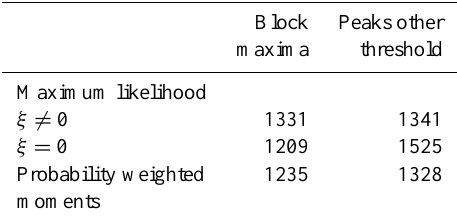
Table 1. Estimated 100-year return levels.